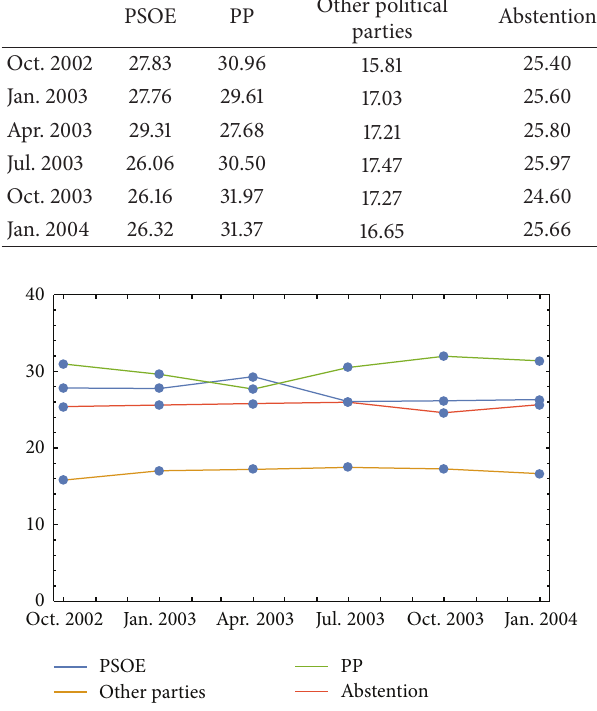
Figure 1: Evolution of the percentage of voting intention and abstentioninCISsurveysfromOctober2002untilJanuary2004,the last one before elections of March 14, 2004 [12]. Only in April 2003, the PSOE voting intention was above the one of the PP. According to [2], this happened because public opinion in Spain was more widely opposed to the country’s involvement in the Iraq war at the beginning of 2003. Table 2: Results (percentages) of the elections of Mar. 14, 2004 [13].